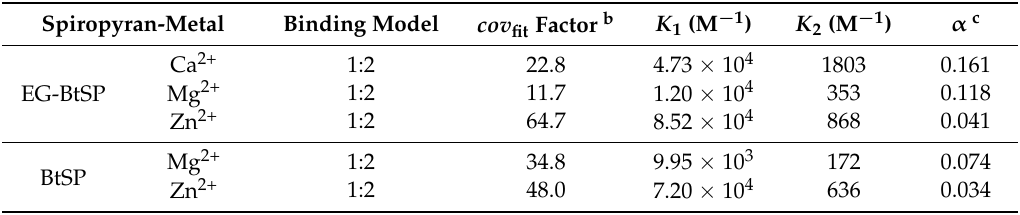
Table 1. Plausible binding model, K 1 , K 2 , and interaction parameter ( α ), and relative quality of fit for the complexation of EG-BtSP and BtSP toward metal ions obtained from UV-VIS spectroscopy at 298 K in acetonitrile a .